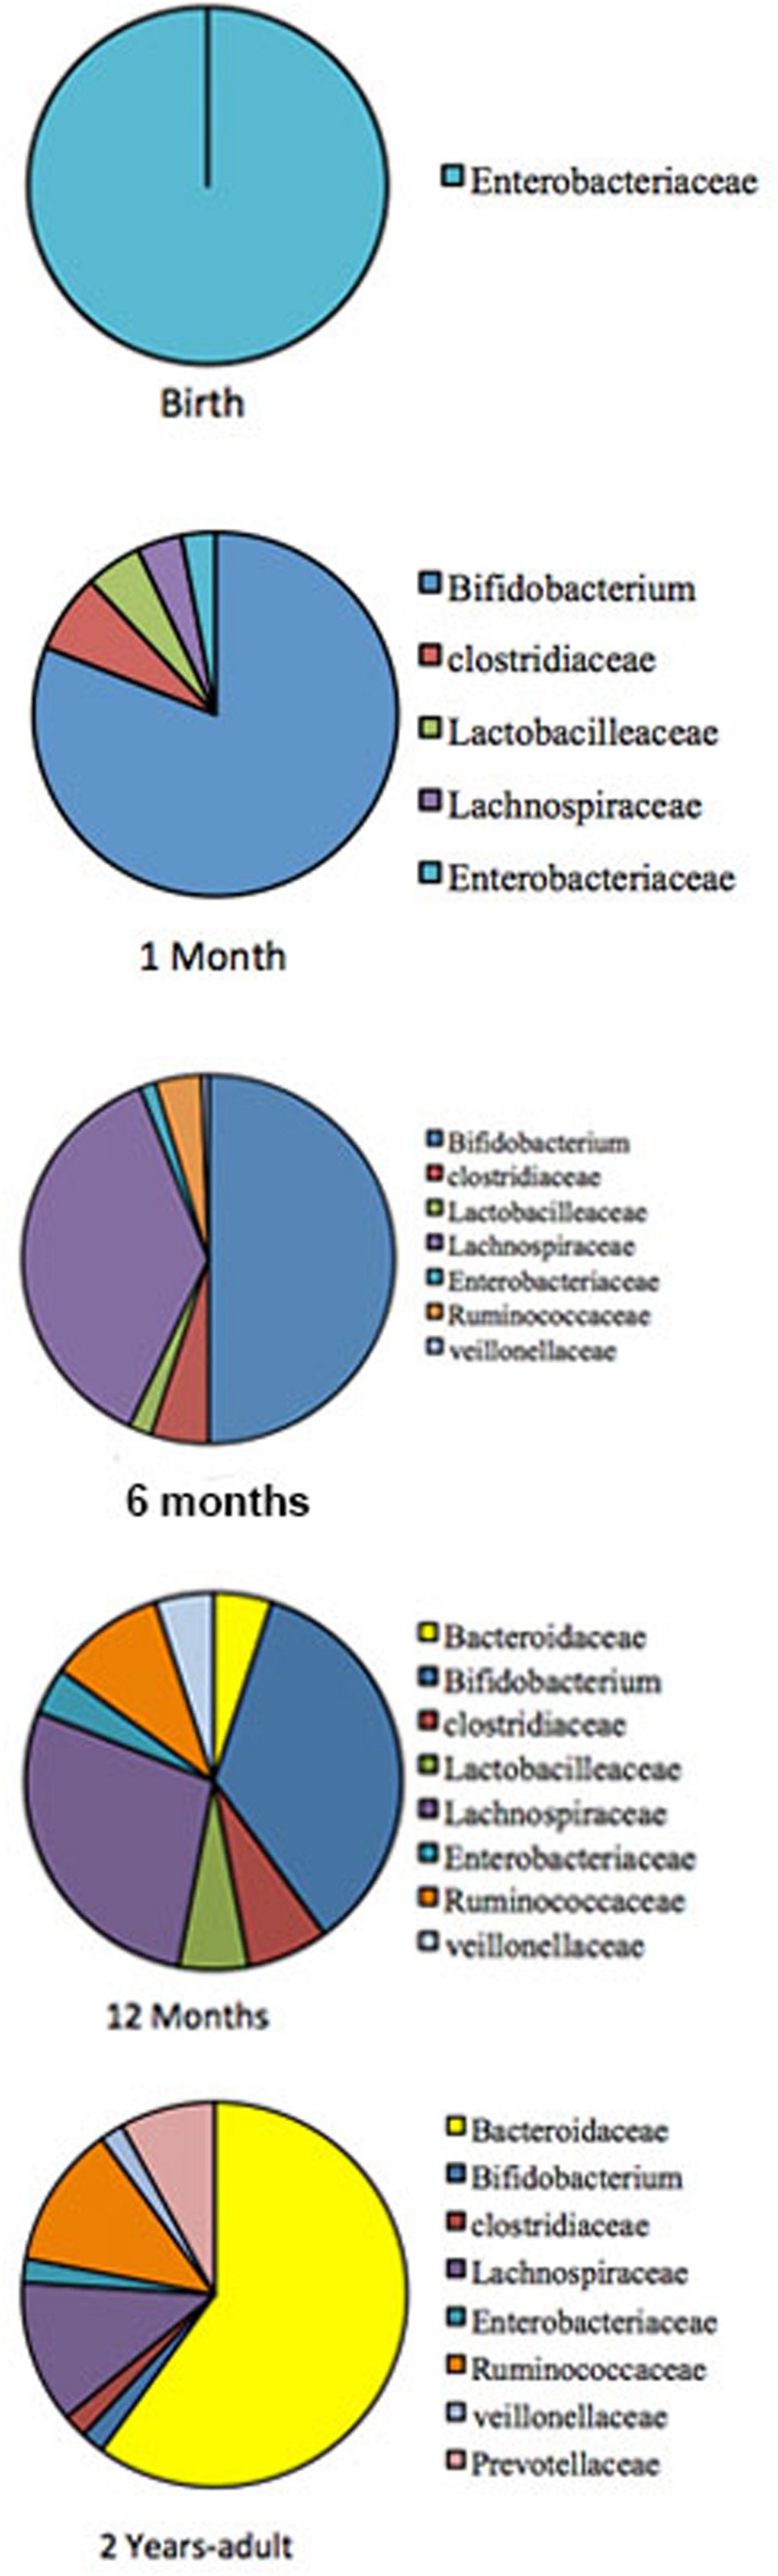
The pattern of GIT microbiome development during a child development. Pie charts are showing profusion of the bacterial taxa at different development stage. The gut-microbiome of the new born is primarily colonized by Enterobacteria (Gosalbes et al., 2013). During the first month, Bifidobacterial species pre-dominate in the gut (Koenig et al., 2011), but at around 4–6 months is convoyed by an increase of clostridial species. Later, the microbiome composition consists of mainly Bacteroidaceae, Lachnospiraceae, and Ruminococcaceae, which then remains stable into adulthood (Fanaro et al., 2005; Morelli, 2008; Lozupone et al., 2012).